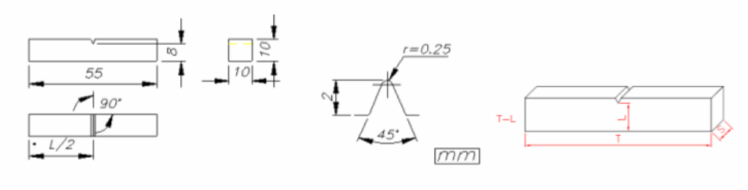
Figure 1. Schematic representation of ISO-V Charpy specimens.